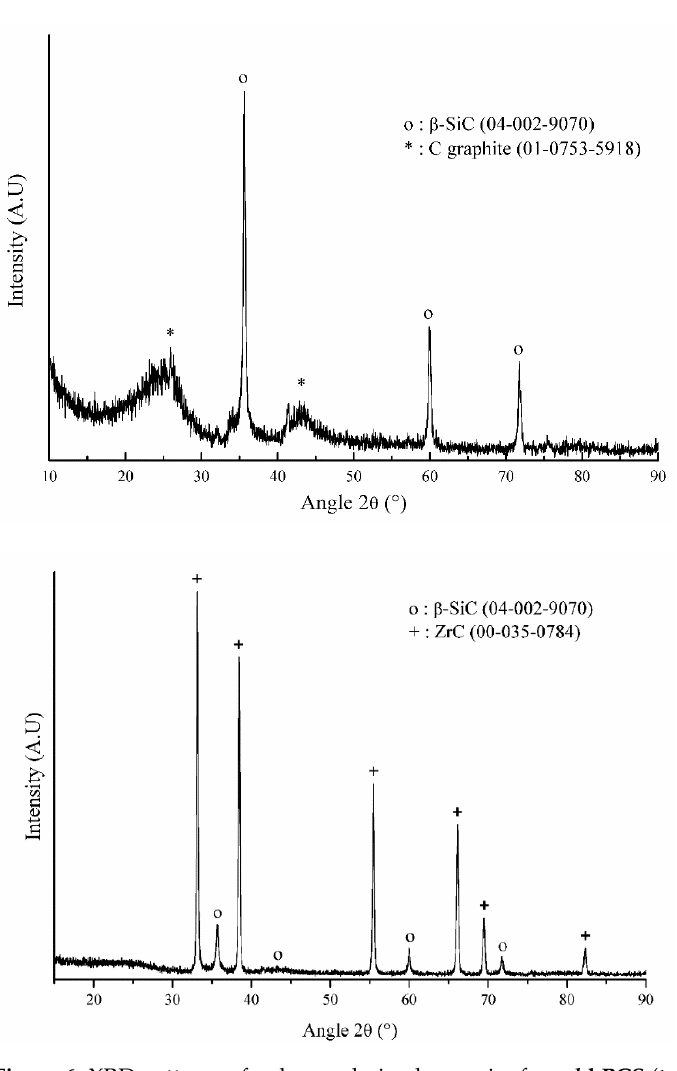
Figure 6. XRD patterns of polymer-derived ceramics from l -hPCS ( top ) and l -hPZCS ( bottom ).